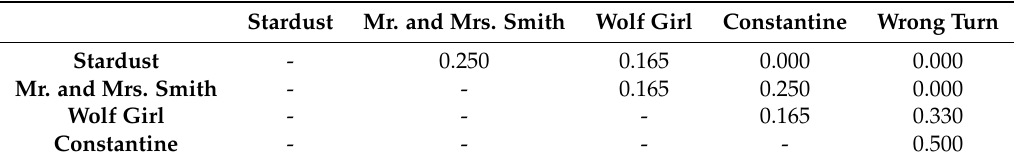
Table 2. An item based similarity metrics based on items